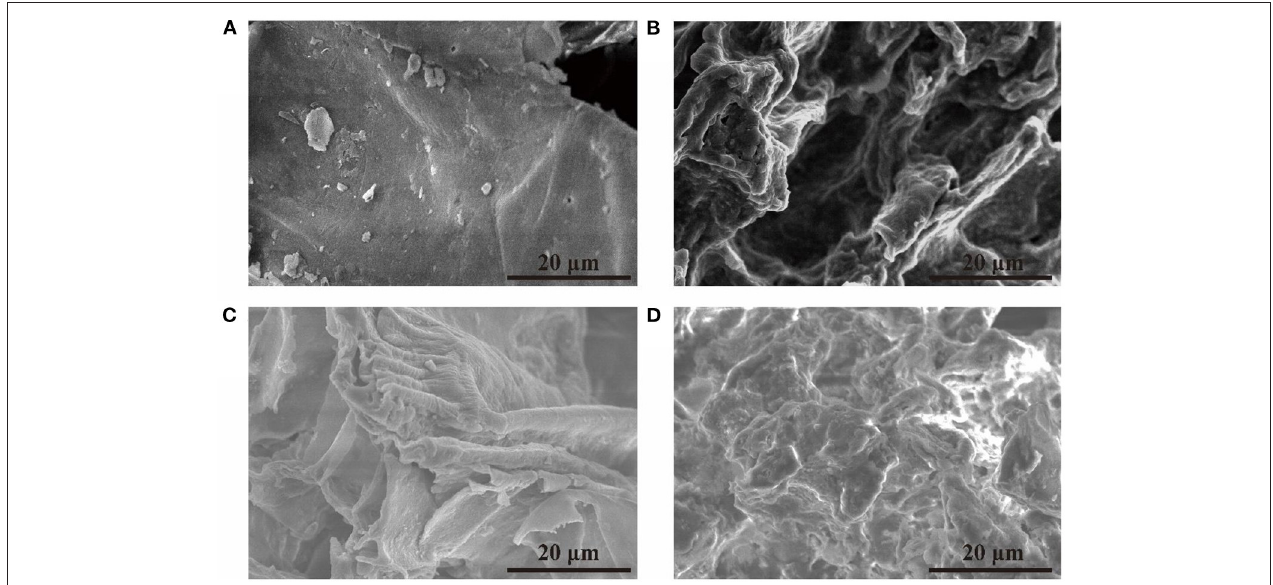
FIGURE 2 | The SEM images of sugarcane bagasse with different pretreatments. (A) Without pretreatment, (B) with ultrasonic-assisted single alkali pretreatment, (C) with ultrasonic-assisted mixed alkali pretreatment, (D) with ultrasonic–assisted mixed alkali pretreatment and enzymatic hydrolysis.